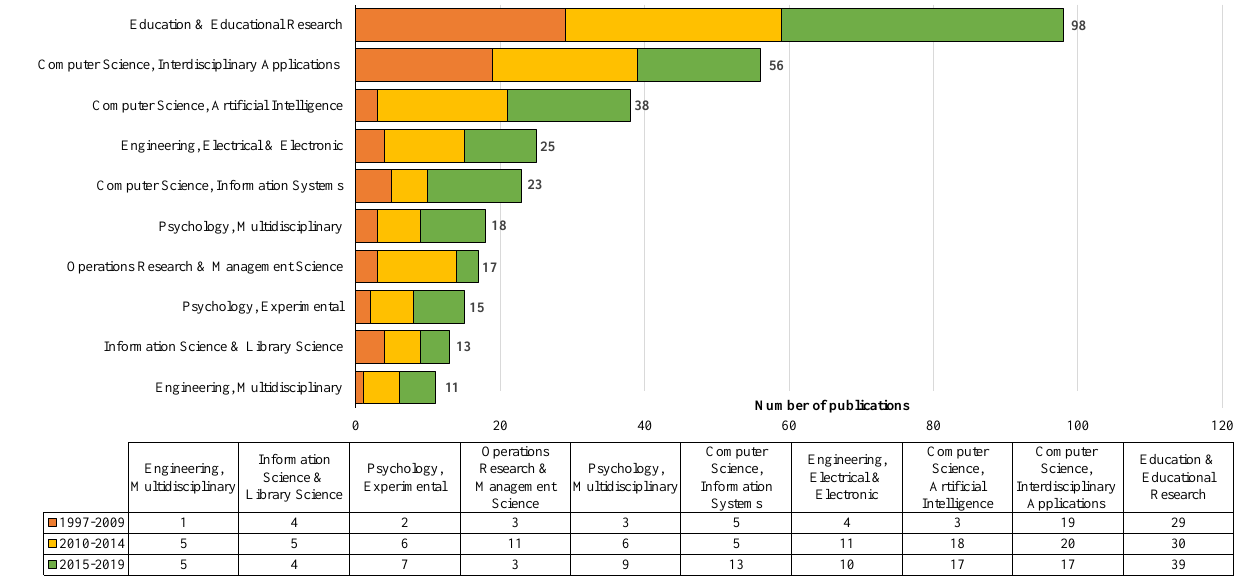
Published Literature in the Top 10 Research Areas by Total Number of Publications, 1997 –